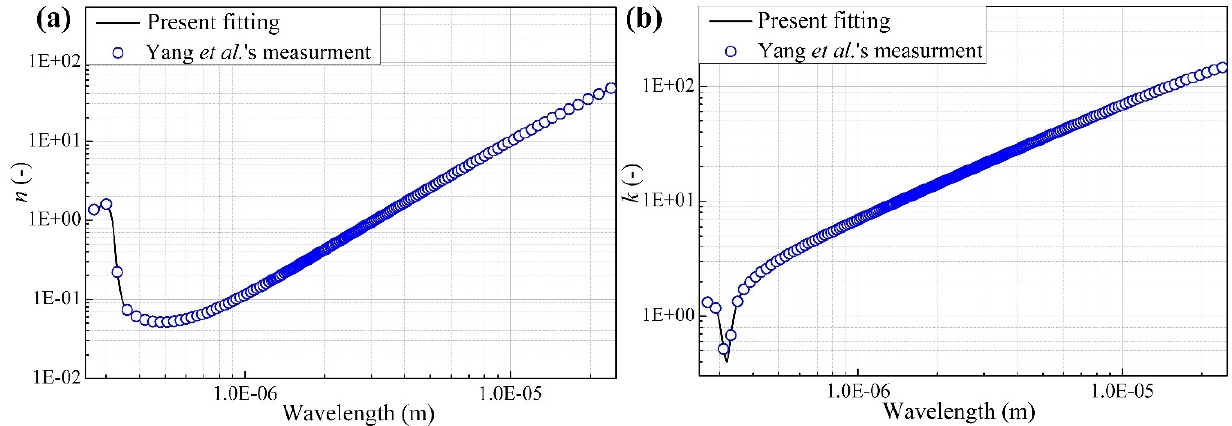
Figure 2. The optical constants of silver versus wavelength: ( a ) refractive index; ( b ) extinction index.